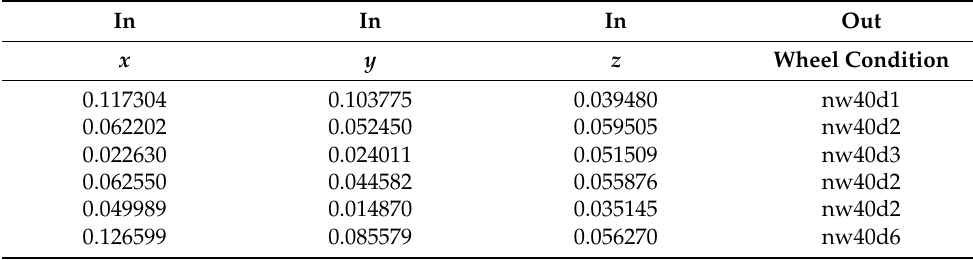
Table 3. An excerpt from the learning data table. In In In Out x y z Wheel